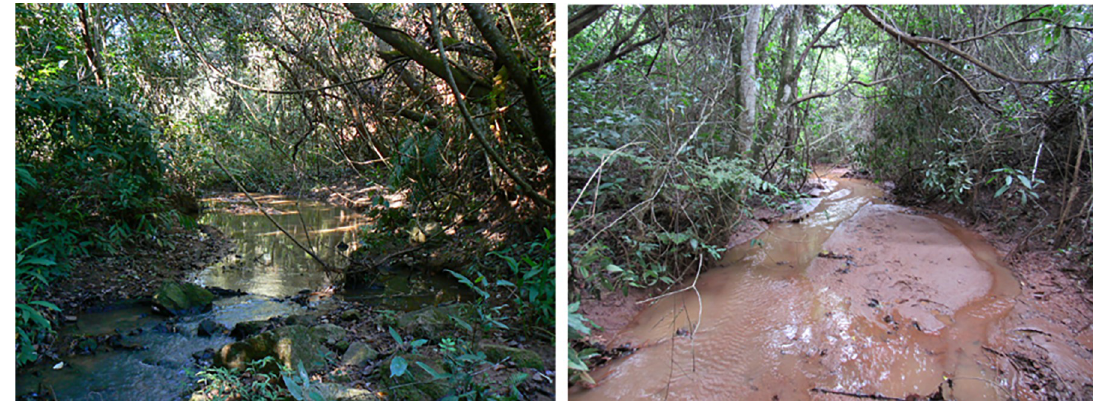
Fig 1. Images of stretches of streams studied in Catal ã o, GO, Brazil. (a) Note the presence of the preserved riparian forest and the absence of evidence of silting in the current reference (RS). (b) The silting state of the degraded stream (DS). Photos: Cla´udio Tavares-Jr. (Personal